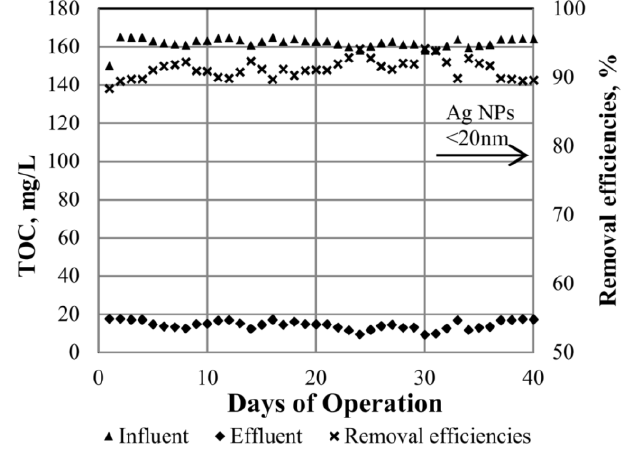
Figure 6. The impact of AgNPs on TOC removal in an SBR [107].